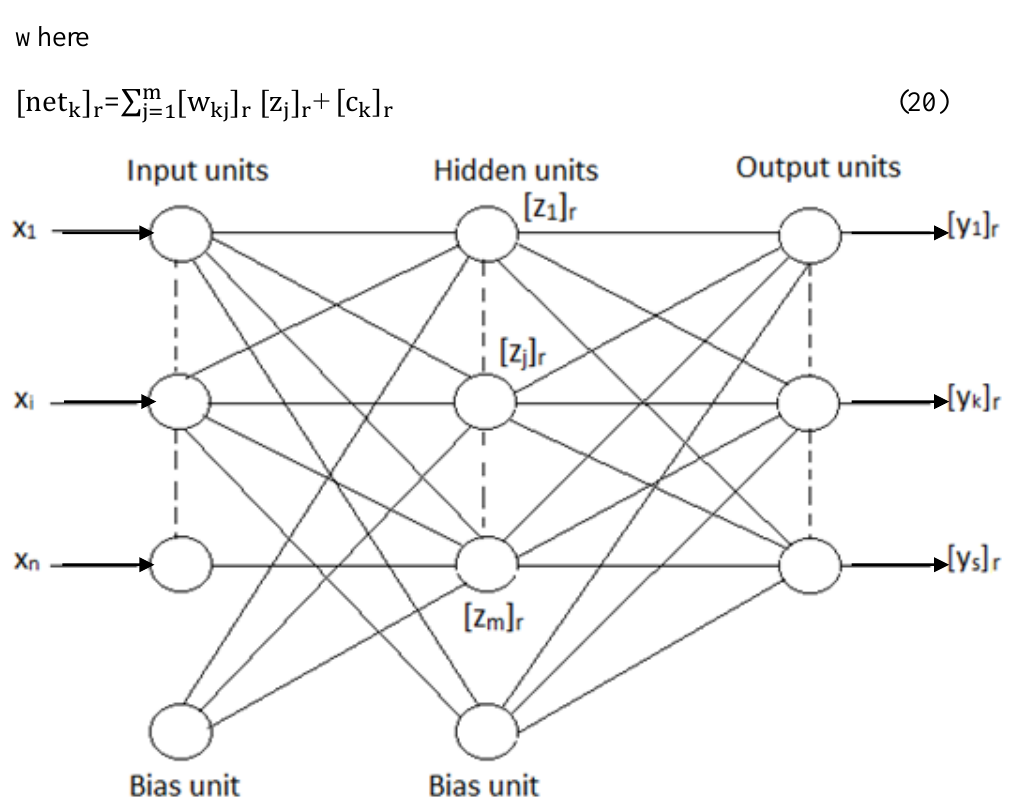
Fig. (1) Three-layer feed forward fuzzy neural